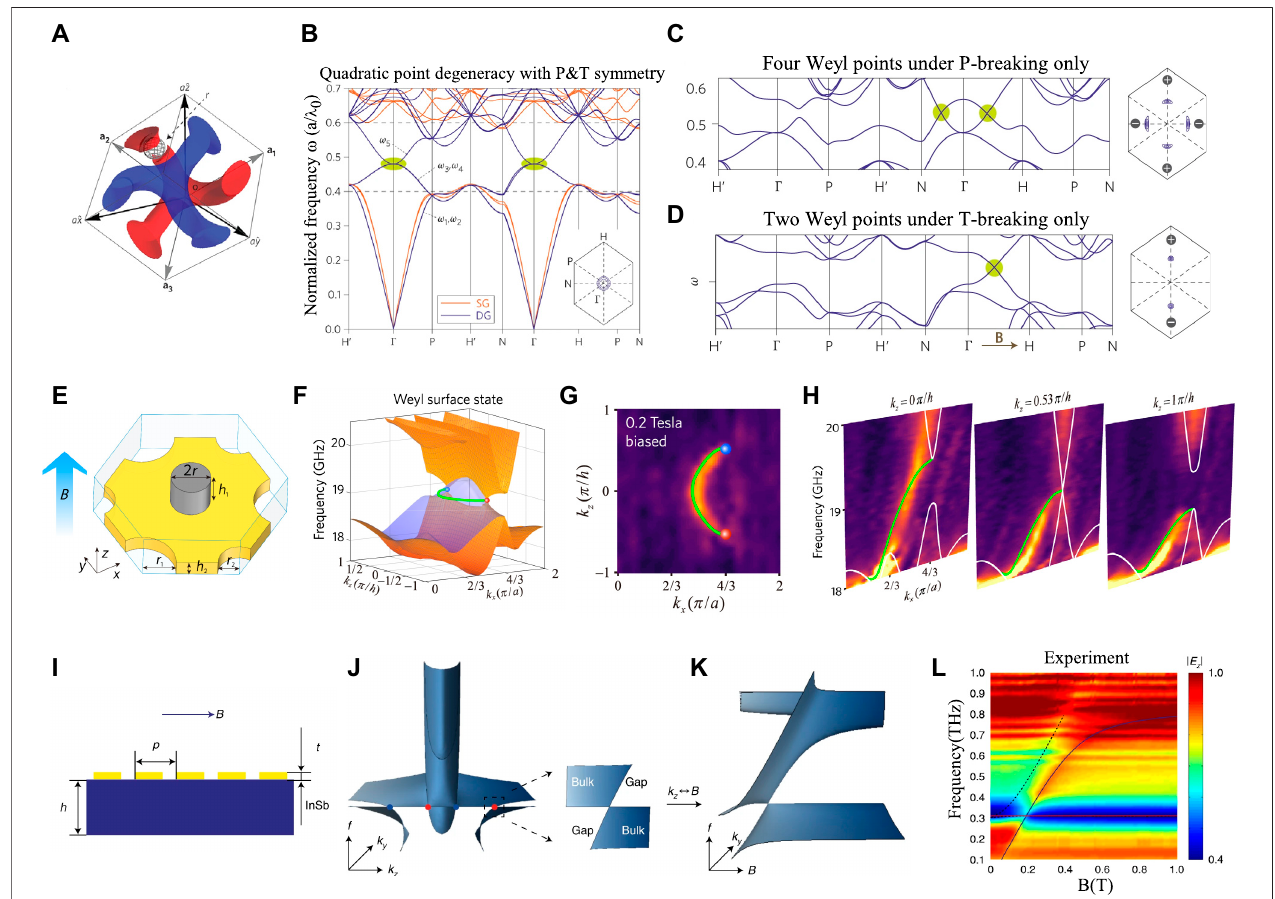
FIGURE 2 | 3D photonic Weyl semimetals by breaking T [24]. (A) The unit cell of double gyroid (DG) photonic crystals. (B) The band dispersion of original DG photonic crystal (blue line) and single gyroid (SG) photonic crystal (red line). (C) The band structure with only P -breaking by placing one air-sphere in only one gyroid, wheretwopairsofWeylpointsappear. (D) Thebandstructurewithonly T -breakingbyapplyingamagnetic fi eldtotheDGphotonicmadeofgyroelectricmaterial,where one pair ofWeyl points appears. (E) The unit cell ofthe gyromagnetic photonic crystal [48]. (F) Simulated band structure under amagnetic fi eld of 0.2 T. The Fermi arcisdonatedbyagreenline. (G) MeasuredsurfaceprojectionsofsinglepairofWeylpointsandtheassociatedFermiarc. (H) Measuredsurfacedispersionsonthefront surface for k z (cid:1) 0, k z (cid:1) 0 . 53 π / h , and k z (cid:1) π / h , respectively. (I) Schematics of the sample with a metal grating on the top of the InSb substrate [52]. (J) Simulated band structure of the magnetized plasma with B (cid:1) 0.19 T. (K) Simulated band structure with k z substituted by B . (L) Experimentally measured re fl ection